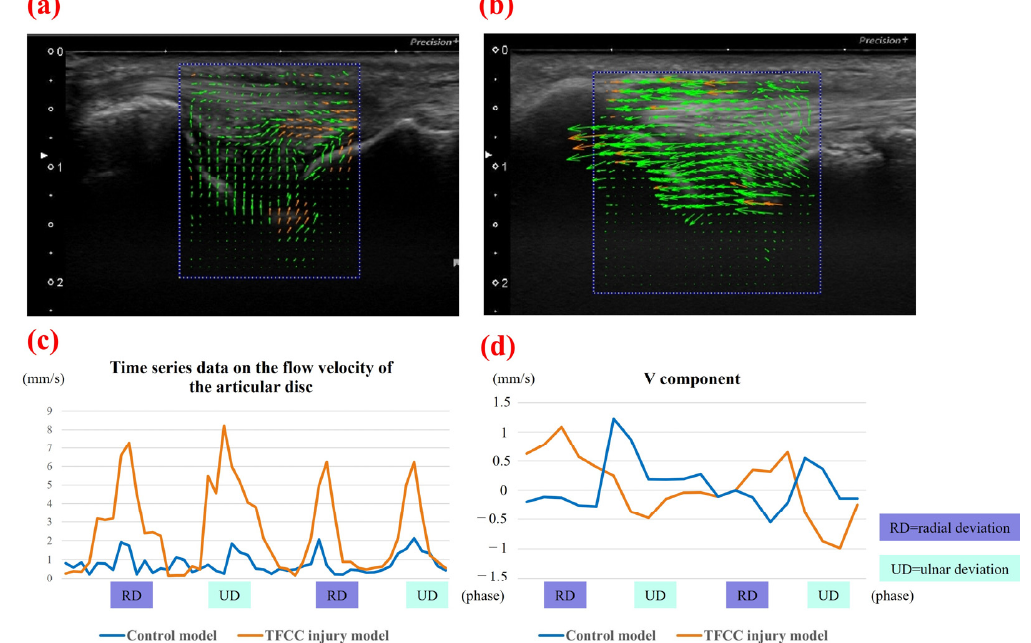
Figure 7. Flow PIV fluid measurement software of ( a ) the control model and ( b ) the TFCC injury model. ( c ) Representative data of the time series data on the velocity magnitude of the articular disc. Flow velocity was significantly higher in the injury group during both radial and ulnar devi- ation. ( d ) Representative data of the v-component. The v-component is moving in different vectors in the control group and the injury group.